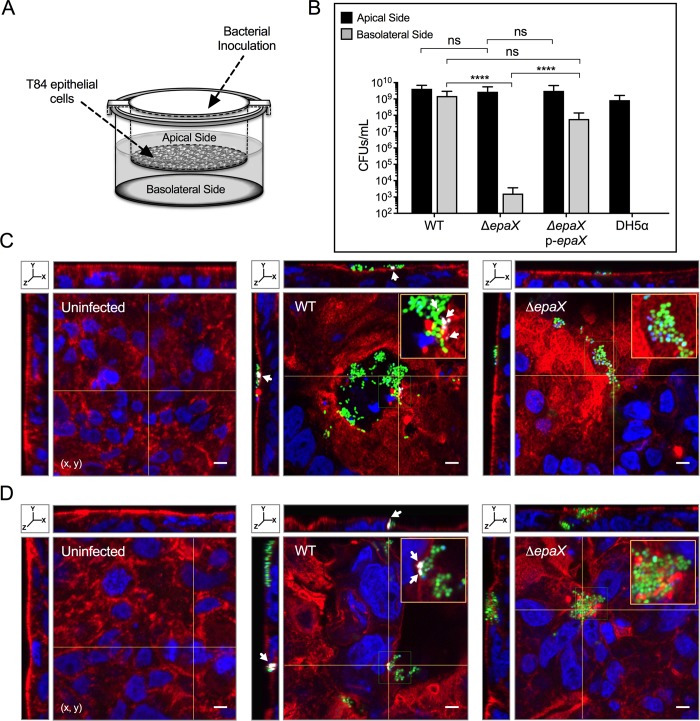
E. faecalis strains devoid of polyGlcNAc-containing polysaccharides demonstrate defective translocation through human intestinal epithelial cell monolayers.(A) Scheme of the two-chamber translocation system. E. faecalis VE14089 WT and derived strains inoculation occurred at the apical side. T84 human intestinal epithelial cell monolayers grown on filters separate the apical side from the lower chamber. (B) Colony forming units (CFUs/mL) of viable bacterial cells that did not pass through the monolayer (apical side) or translocated to the basolateral side after 8 hours of incubation. Escherichia coli DH5α was used as a negative control (mean±SE; n = 5; ****P <0.0001 for both the one-way ANOVA and Tukey’s multiple comparison test). (C and D) 3D reconstruction of confocal immunofluorescence images (x, y, z) of T84 human cell monolayers uninfected (left) or infected for 2 (C) or 6 (D) hours with WT (center) or ΔepaX (right) constitutively expressing GFP (green fluorescence). Alexa Fluor-594 coupled phalloidin and DAPI were used to stain the epithelial cell actin (red fluorescence) and nucleus (blue fluorescence), respectively. To visualize polyGlcNAc-containing polymers, epithelial cells and enterococci co-cultures were treated with mAb F598 antibody and reacted with the antihuman IgG conjugated to Alexa Fluor-647 (gray fluorescence; white arrows). The yellow lines mark the intersection point were the x, z (top) and y, z (left) orthogonal views of reconstructed Z-sections were taken. Scale bar: 5 μm. The orange square represents a 2X-magnified view of the selected area in x, y planes (green square).